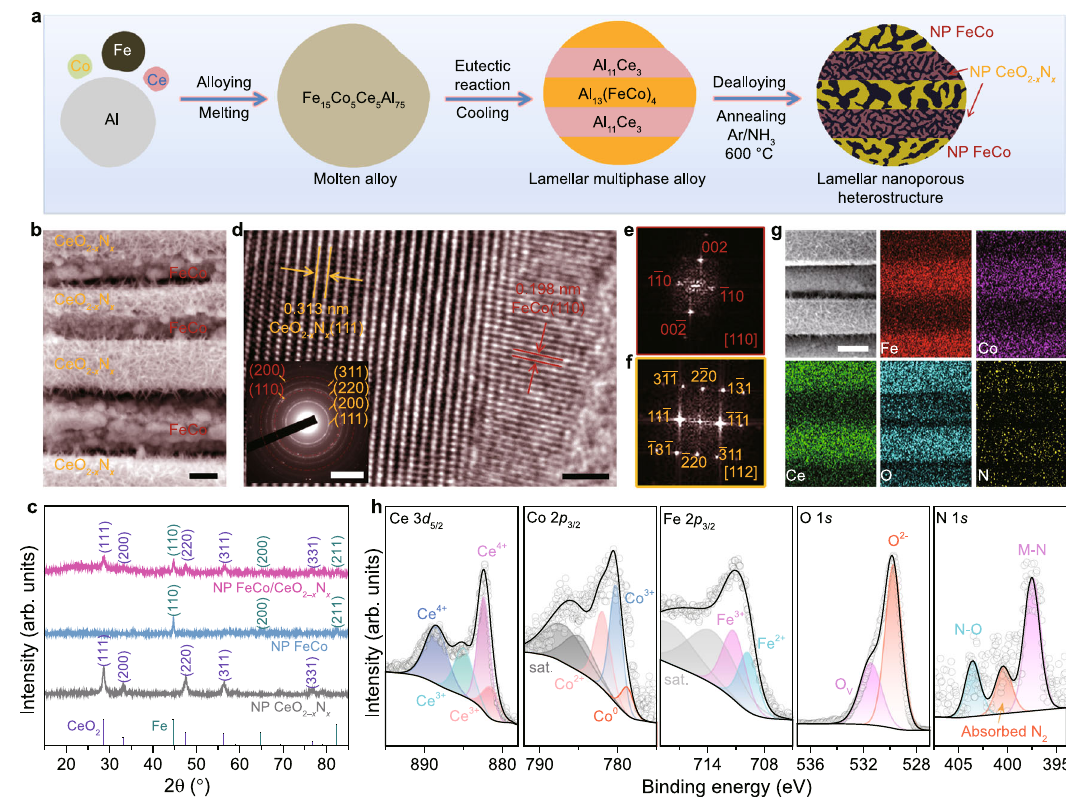
Fig. 1 | Preparation scheme and microstructure of nanoporous FeCo/CeO 2 − x N x electrodes. a Schematic diagram to illustrate fabrication procedure of lamellar nanoporous (NP) FeCo/CeO 2 − x N x composite electrode, during which precursor Fe 15 Co 5 Ce 5 Al 75 eutectic alloy composed of lamella-nanostructured Al 11 Ce 3 and Al 13 (FeCo) 4 intermetallic compounds are prepared by solidi fi cation eutectic reac- tion and then chemically dealloyed in N 2 -purged KOH solution to remove less- noble Al, followed by a thermal nitri fi cation process at 600°C in Ar/NH 3 atmo- sphere. b Top-view SEM image of NP FeCo/CeO 2 − x N x composite electrode, dis- playing an architecture composed of periodically alternating hierarchical nanoporous FeCo alloy and nanoporous CeO 2 − x N x lamellas. Scale bar, 200nm. c XRD patterns of NP FeCo/CeO 2 − x N x composite electrode (pink), as well as its